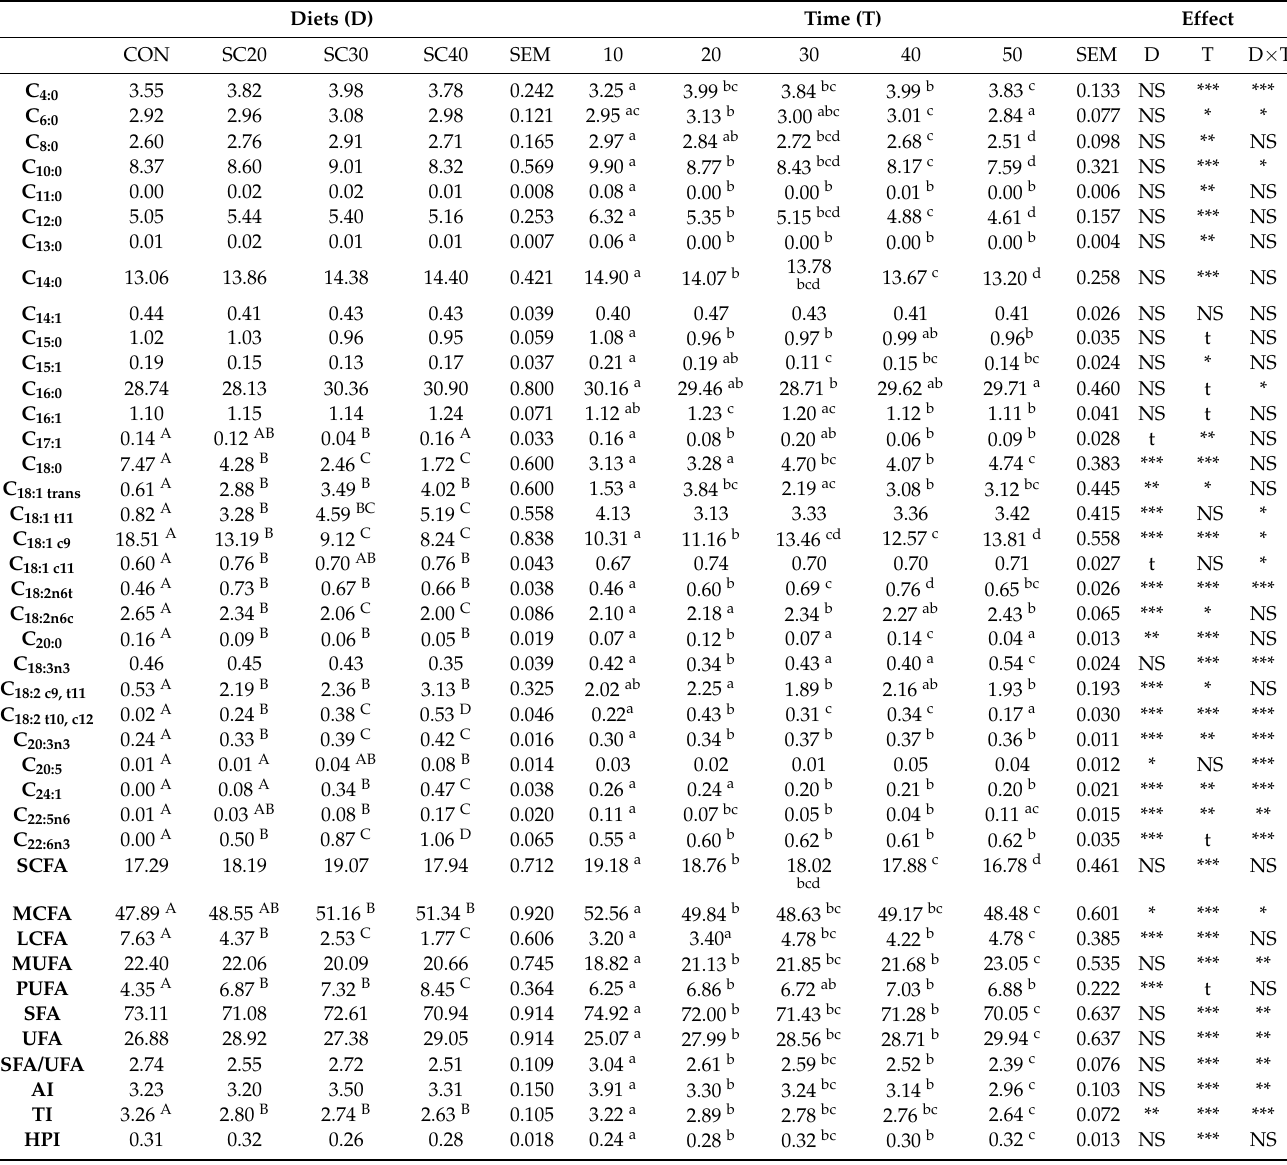
Table 3. The mean individual fatty acids (FA) (% of total FA), FA groups, and health indexes of milk of ewes fed diets (CON, SC20, SC30, SC40) with different levels of Schizochytrium spp. microalgae (20, 30 and 40 g) throughout the experimental period (10, 20, 30, 40, 50 experimental